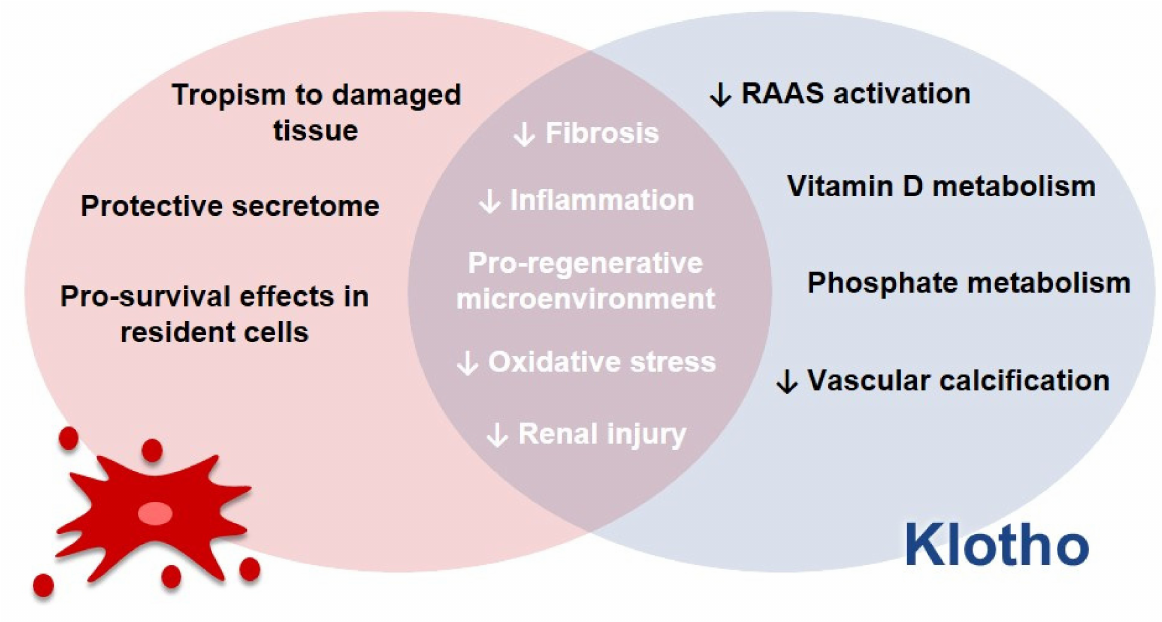
Figure 5. Synergism between mesenchymal stem cells (MSCs) and Klotho. We speculate, based on data in the literature, that, in vivo, the properties of MSCs, such as tropism to damaged tissues, their protective secretome and pro-survival effects in resident cells, would act alongside the beneficial effects of Klotho, such as its reduction of renin-angiotensin-aldosterone-system (RAAS) activation, its influence on vitamin D and phosphate metabolism and the reduction in vascular calcification, As a result, there would be reduction in fibrosis and inflammation, improvement of pro-regenerative conditions for the damaged tissue, as well as a reduction in oxidative stress and renal injury in